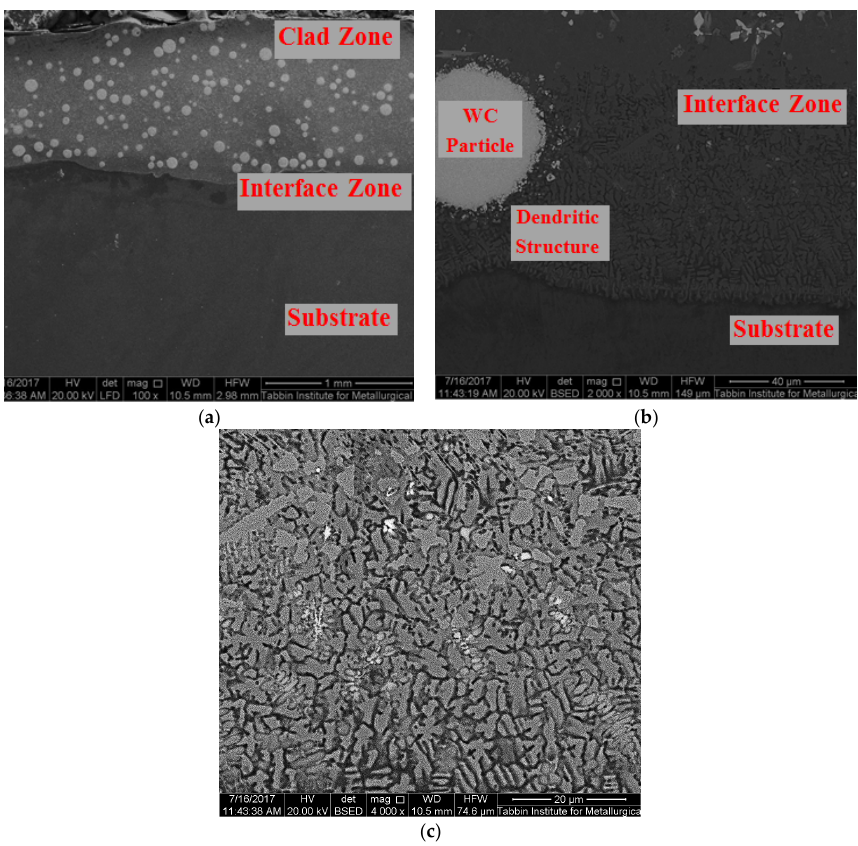
Figure 7. SEM micrographs of sample processed at specific heat input of 59.5 J·mm − 2 : ( a ) whole clad layer; ( b ) interface zone; and ( c ) interface dendritic structure (magnification of 4000×).